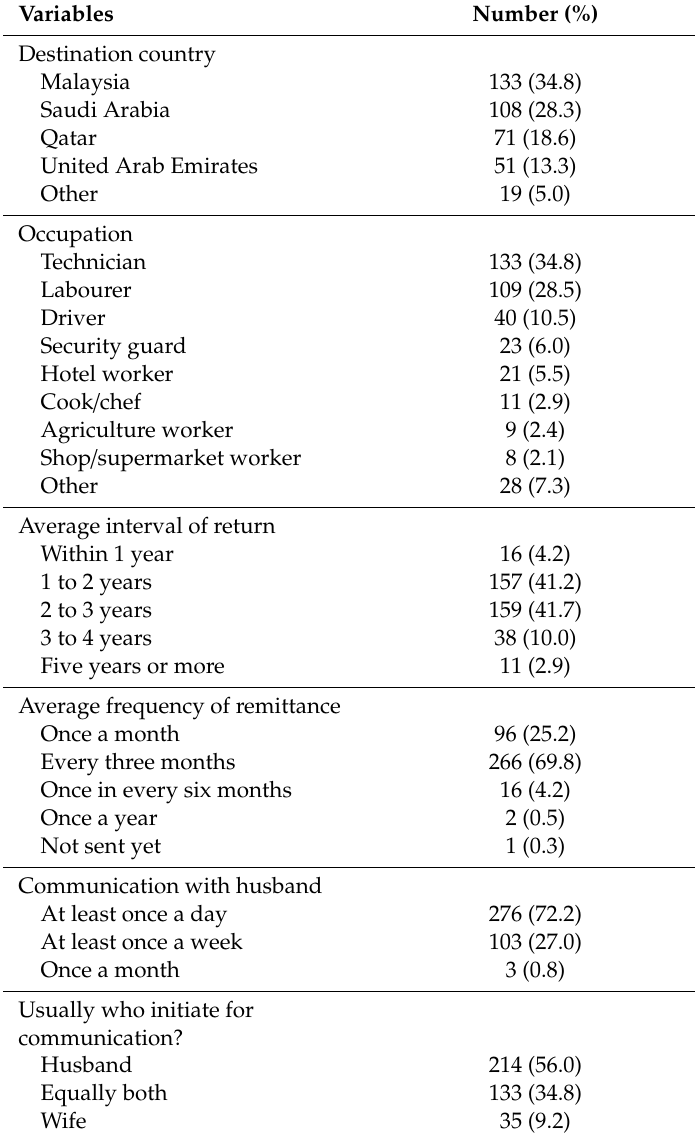
Table 2. Migration related characteristics of participants’